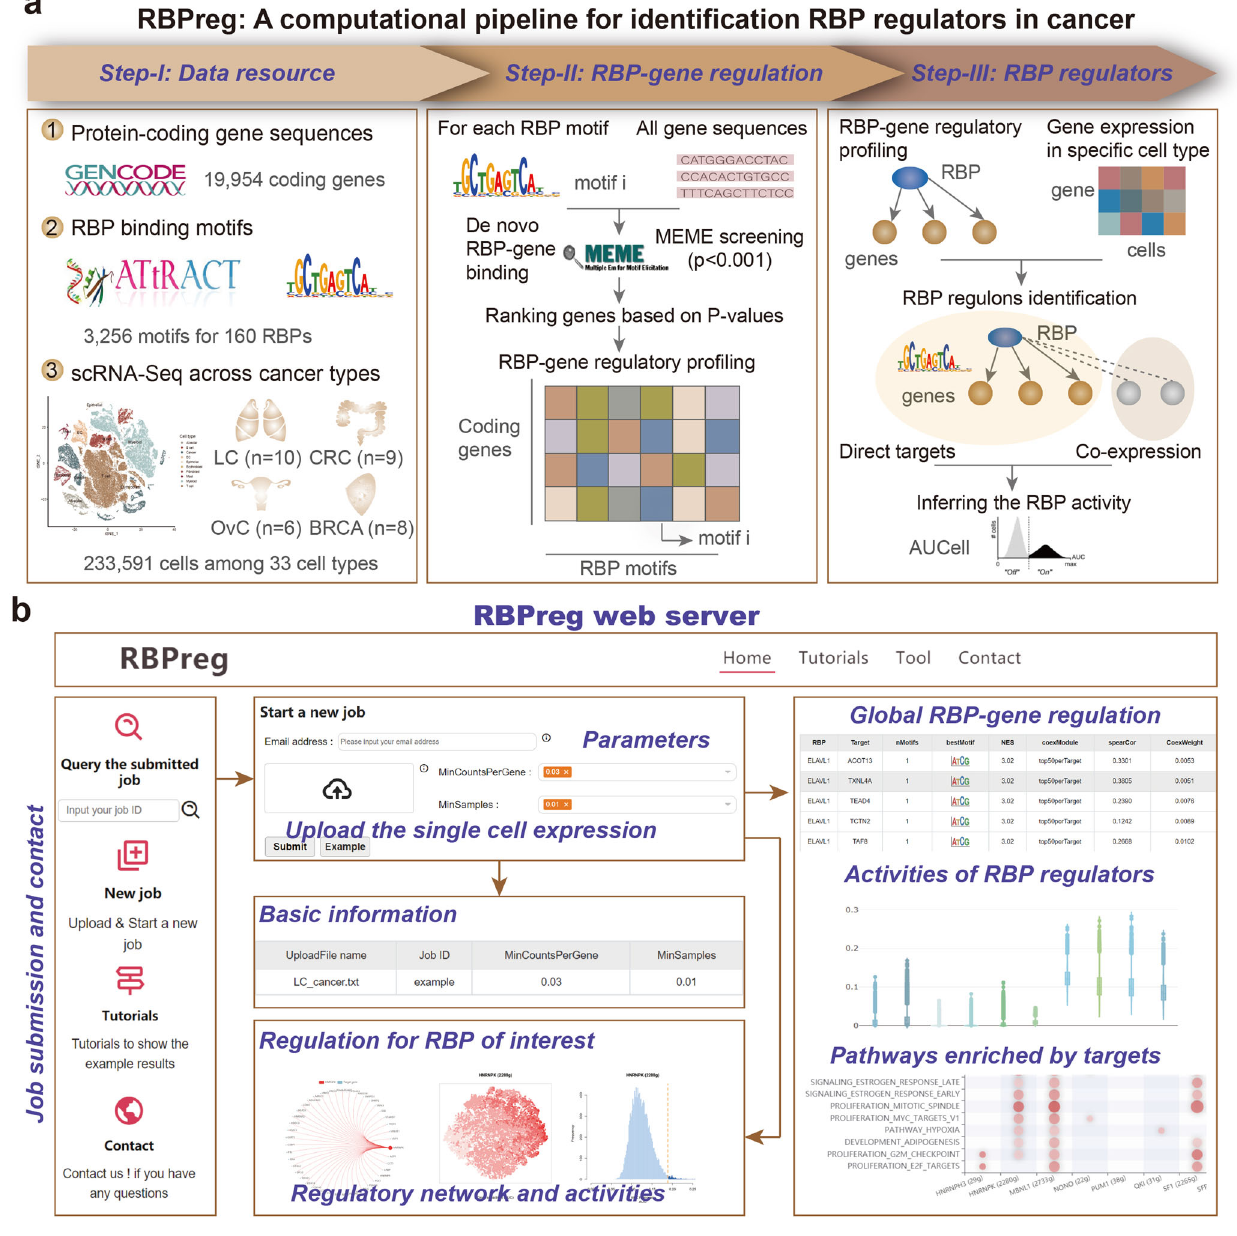
Fig. 1 The RBPreg pipeline for identifying RBP regulators by integrating scRNA-Seq and regulation data. a The work fl ow of RBPreg computational pipeline. b Illustration of the usage of RBPreg web server and the results showing RBP-gene regulation in